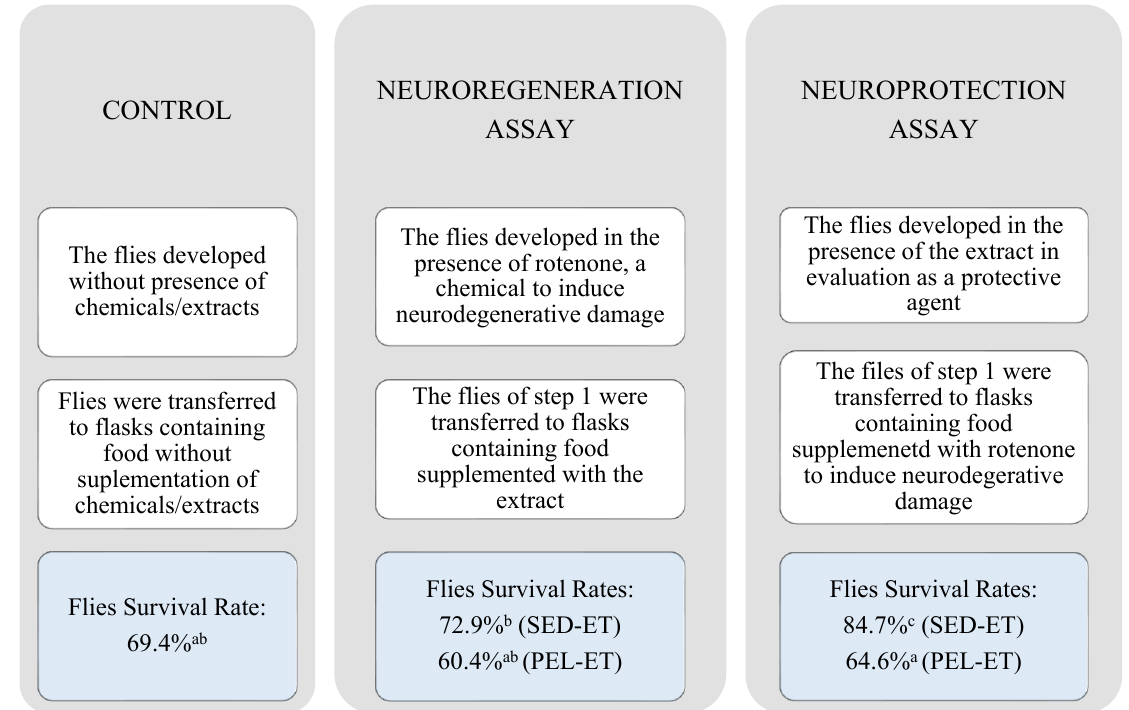
Figure 2. Outline and results of negative geotaxis assay of peels and seeds ethanol extracts in comparison with the control. Different letters indicate statistical difference by Dunn’s test ( p < 0.05). SED-H: seed hexane extract; SED-ET: seed ethanolic extract; PEL-H: peel hexane extract, and PEL-ET: peel ethanolic extract.